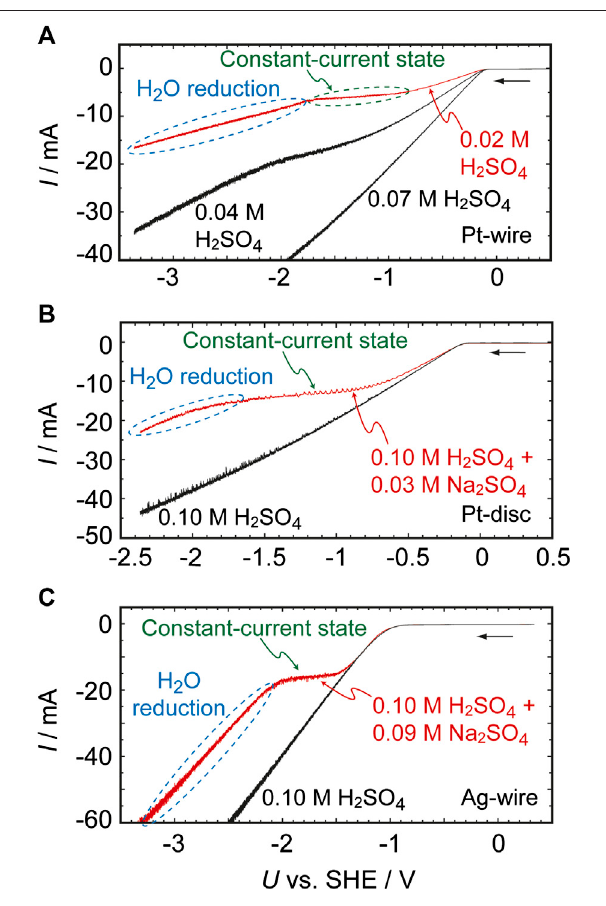
FIGURE 1 | Current ( I ) – potential ( U ) curves for H 2 SO 4 solutions and H 2 SO 4 + Na 2 SO 4 solutions as obtained under controlled potential conditions at a scan rate of 0.01 V s − 1 . The working electrodes were (A) a 0.5 mm diameter, 4 mm long Pt wire, (B) a 2 mm diameter Pt disc, and (C) a 0.5 mm diameter, 4 mm long Ag